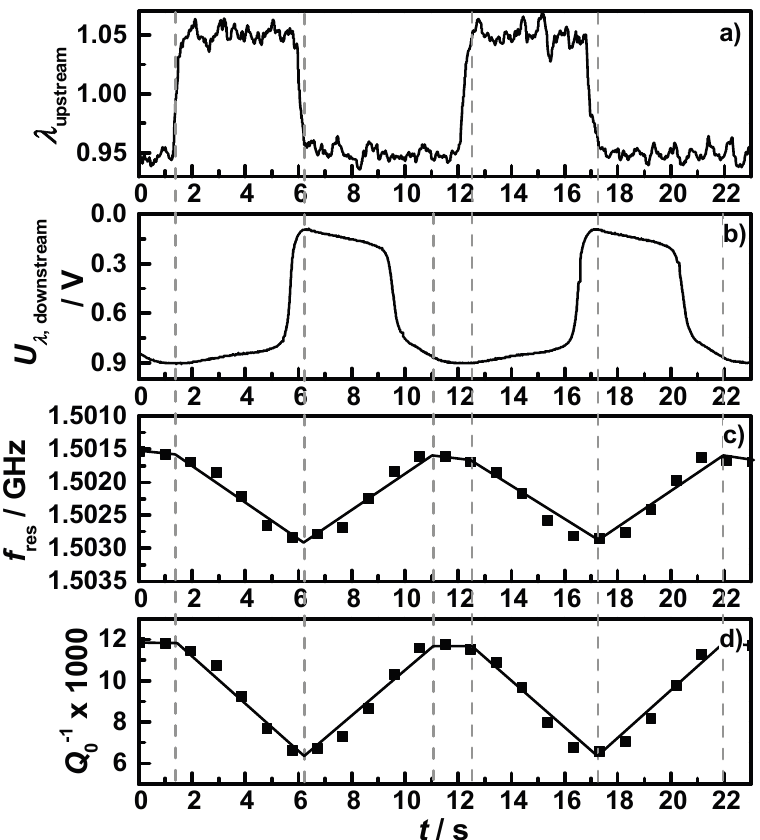
Figure 6. Section of a performed OSC measurement of filter C1 with continuous lean-rich changes at 425 °C: ( a ) the air-fuel ratio λ measured by the upstream broadband lambda probe; ( b ) downstream lambda probe signal; ( c ) the resonance frequency in reverse scale; and ( d ) the reciprocal quality